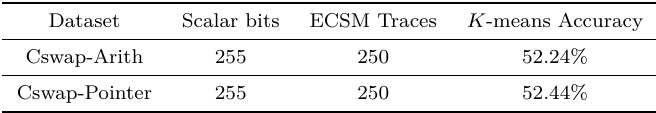
Table 1: Horizontal attack